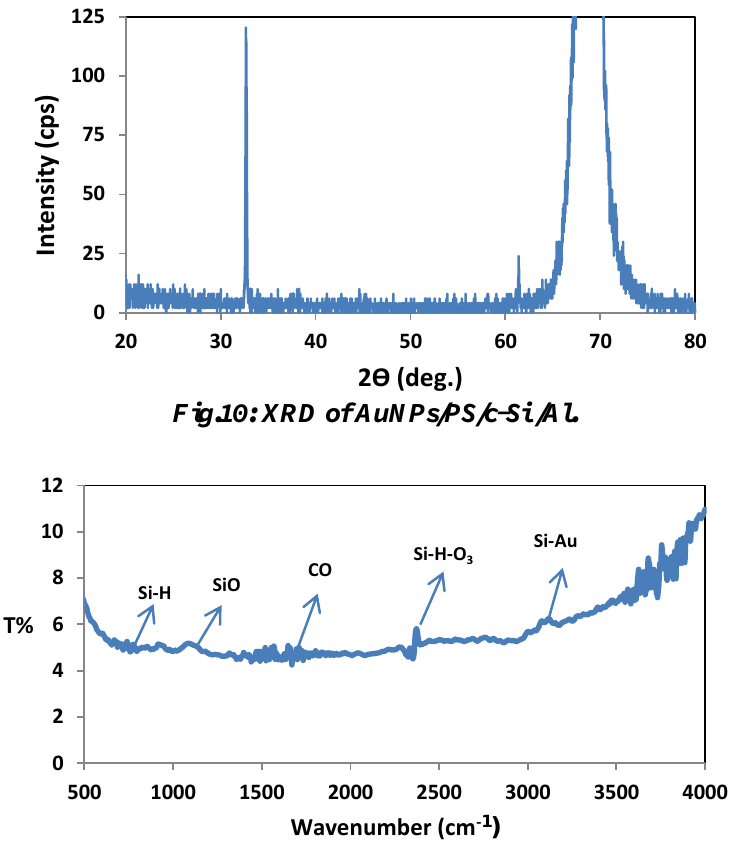
Fig. 11: FTIR spectrum of AuNPs /PS/c-Si when AuNPs prepare at 600